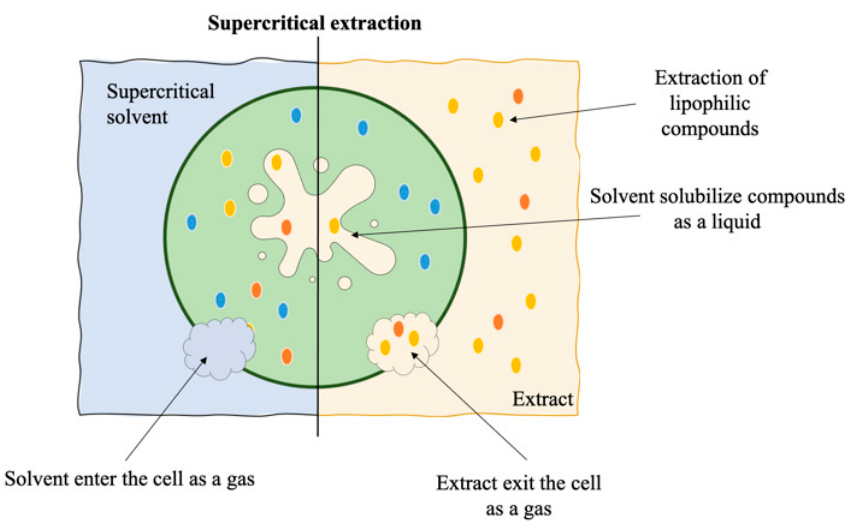
Figure 6. Schematic representation of supercritical fluid extraction (SFE) in microalgae and cyanobacteria cells.